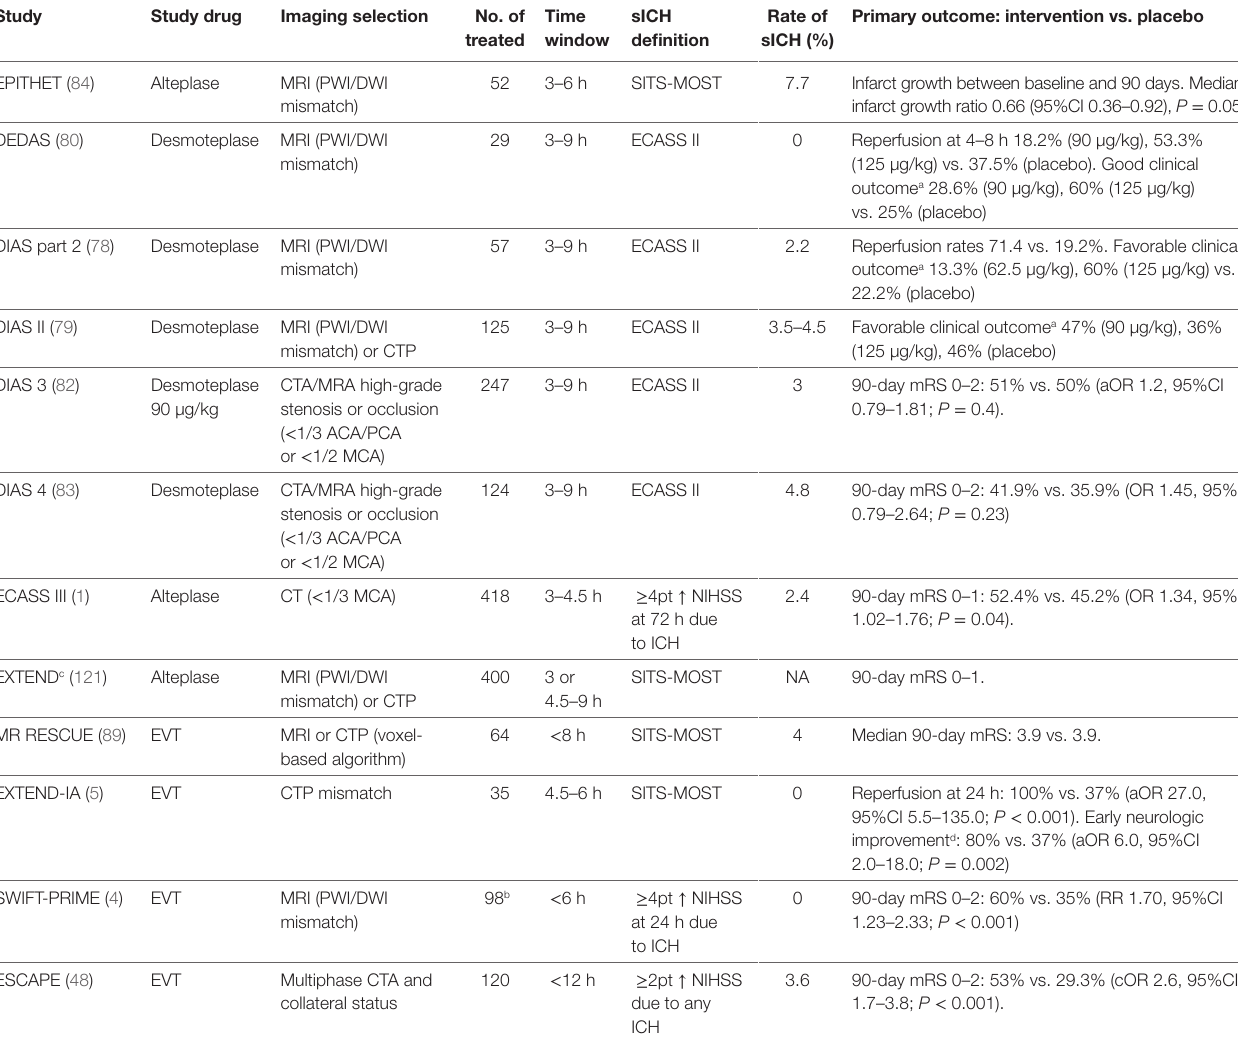
a Combined analysis defined at 90 days as ≥ 8 point improvement or scoring 0 to 1 on NIHSS, score of 0 to 2 on mRS, and a BI score of 75 to 100. b Eighty-three patients treated using PWI/DWI mismatch. Fifteen patients treated based small-core defined as ASPECTS ≥ 6 on CT or MRI. c Trial completed or terminated but not yet published. Trial in progress. d Early neurologic improvement defined as reduction of eight points or more on NIHSS or score of 0 or 1 at 72 h. ACA, anterior cerebral artery; CTA, CT angiogram; CTP, CT perfusion; DWI, diffusion weighted imaging; EVT, endovascular thrombectomy; MCA, middle cerebral artery; mRS, modified Rankin scale; NIHSS, National Institutes of Health Stroke Scale; PCA, posterior cerebral artery; PWI, perfusion weighted